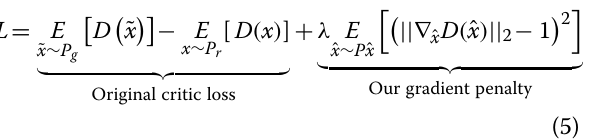
in [26] is to add gradient penalty (GP) to critic loss. The new network model was called WGAN-GP.